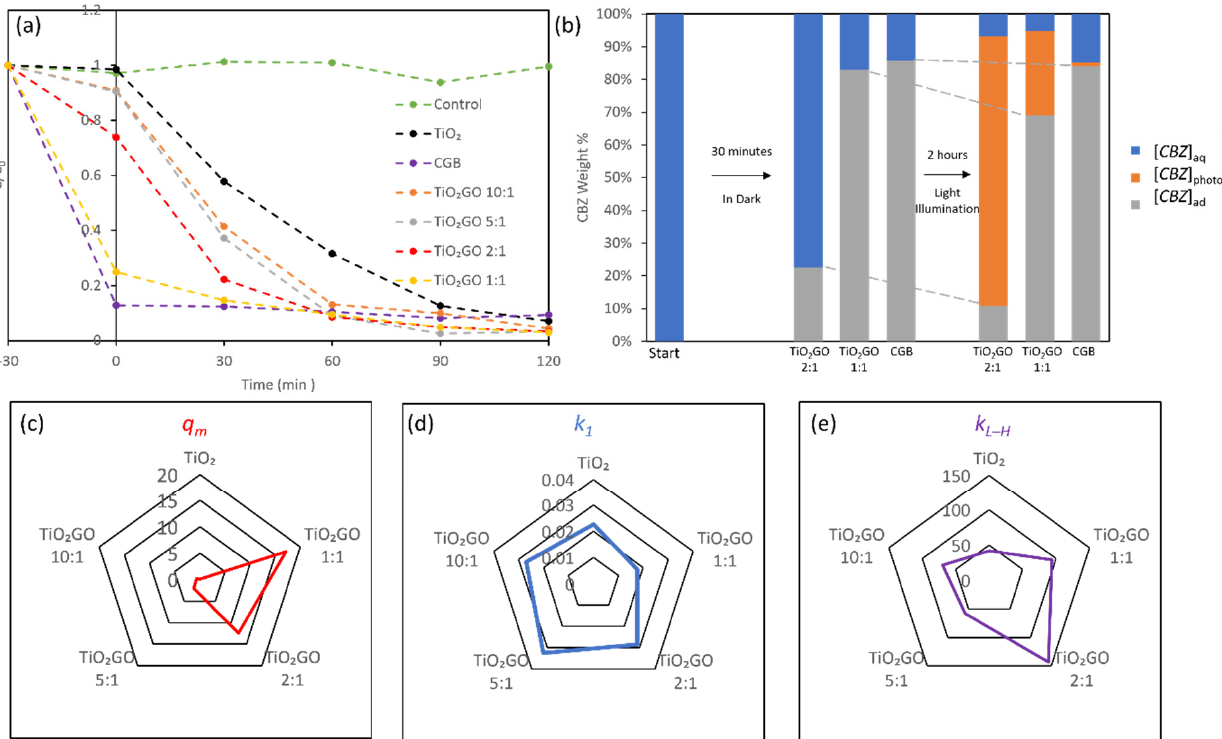
Figure 3. ( a ) C/C 0 plot for CBZ photodegradation in the absence of catalyst (control) and using TiO 2 , CGB, and TiGC as catalysts (different TiO 2 :GO ratios 10:1, 5:1, 2:1, and 1:1. CBZ initial concentration = 1 mg/L, catalyst dose = 0.2 mg/mL; ( b ) the weight proportions of CBZ remaining in aqueous phase [ CBZ ] aq , adsorbed via TiGC [ CBZ ] ad , and photodegraded via TiGC [ CBZ ] photo at different experiment times; ( c ) the comparison of Langmuir maximum adsorption capacity q m (mg/g); ( d ) the comparison of pseudo first-order reaction constant k 1 (min − 1 ); ( e ) the comparison of L-H model reaction constant k L-H (µg L − 1 min − 1 ).